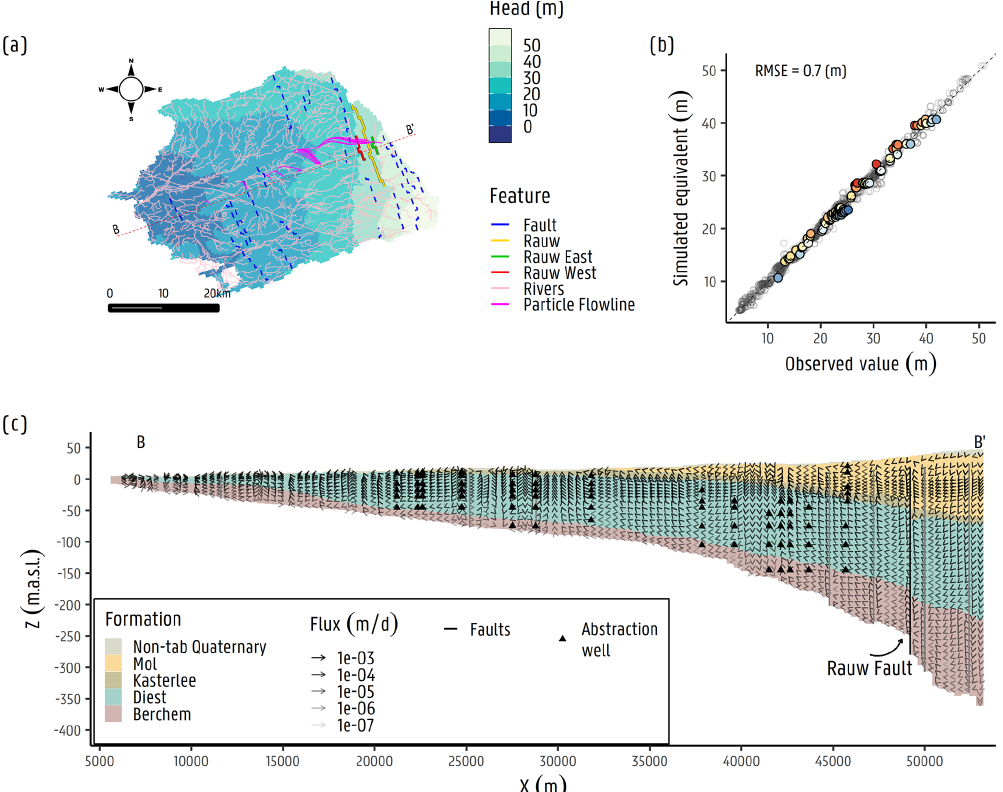
Figure 4. Groundwater flow model results adapted from Casillas-Trasvina et al. (2021). (a) The hydraulic head distribution over the Nete catchment. (b) Scatterplot of simulated equivalents and observed hydraulic heads. (c) Cross section B–B’ with arrows indicating the flow magnitude (md − 1 ) and